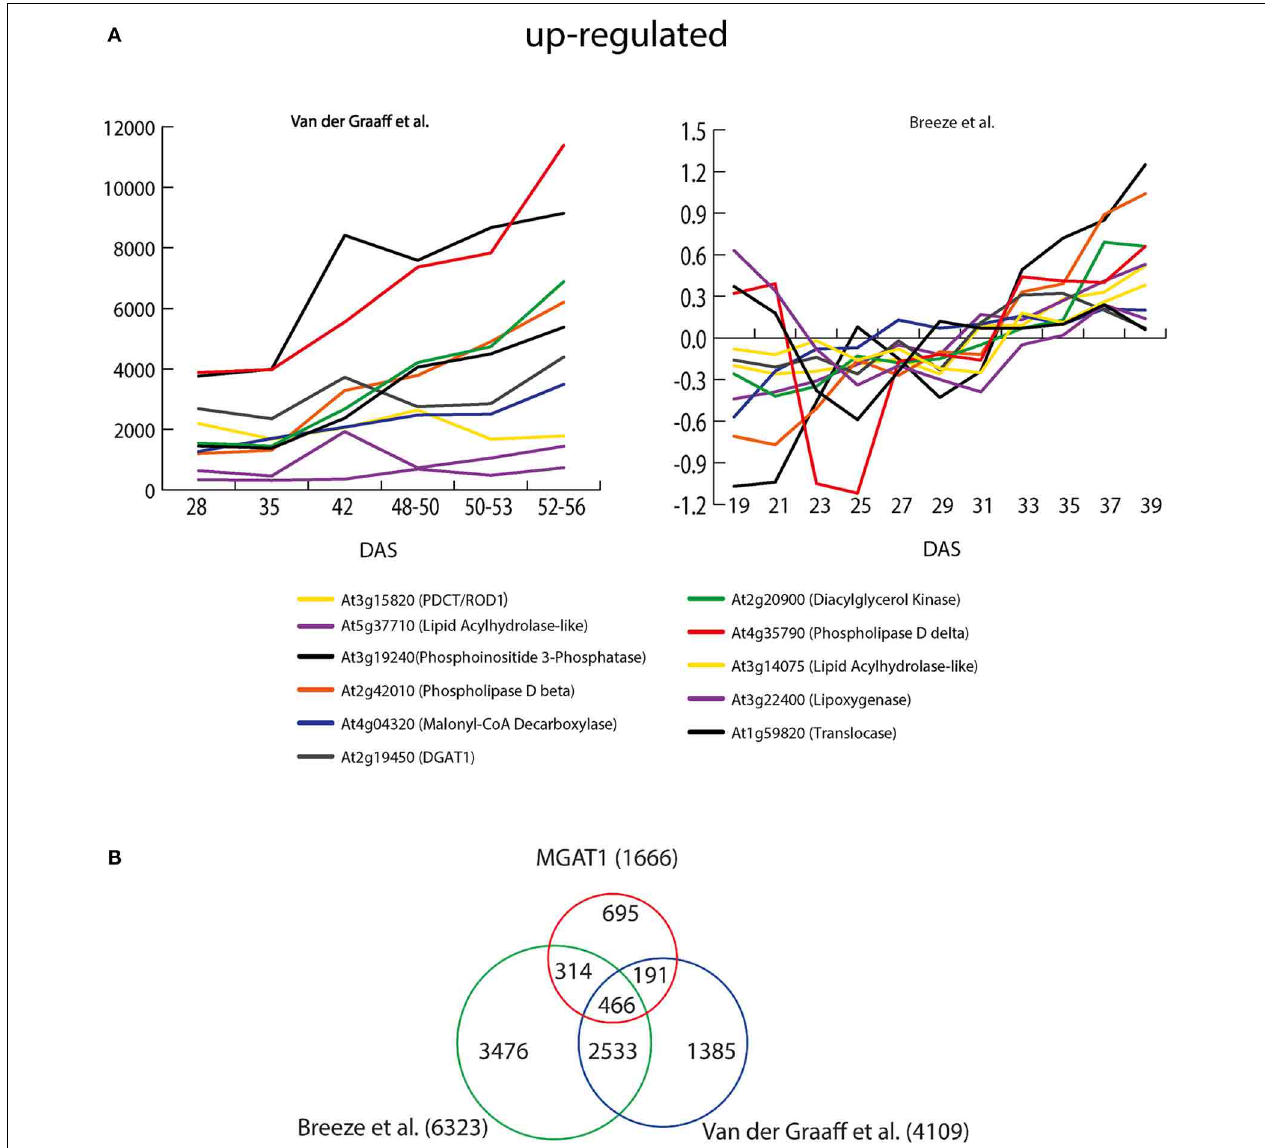
FIGURE 6 | MGAT1 and senescence responsive transcripts. (A) Expression profiles of MGAT1 responsive lipid related genes during senescence. Senescence profiles from two earlier studies (Van Der Graaff et al., 2006; Breeze et al., 2011) were downloaded from Troncoso-Ponce et al. (2013) database and shown. Eleven out of twelve